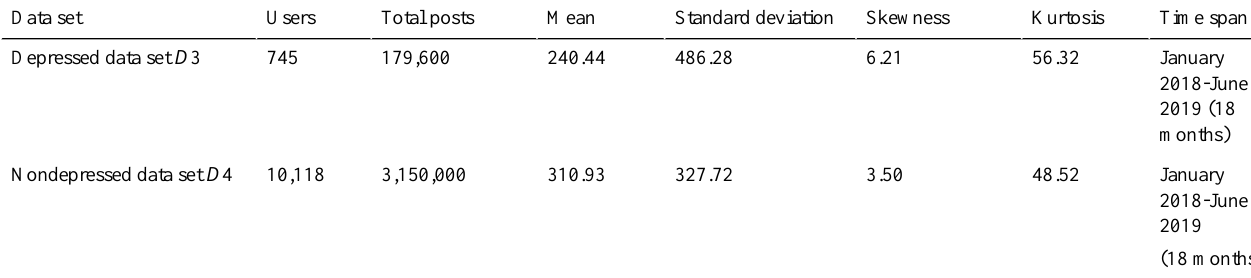
Table 6. Details of the data set for depression